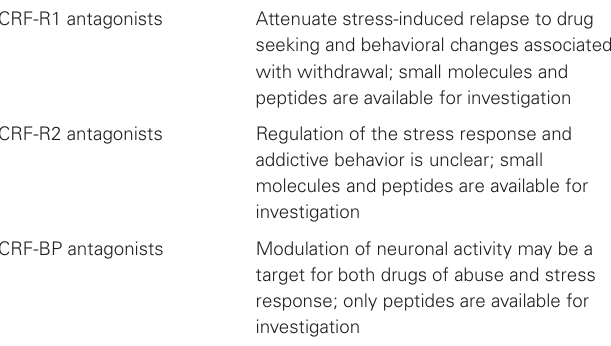
Table 2 | Involvement of the CRF binding in addictive